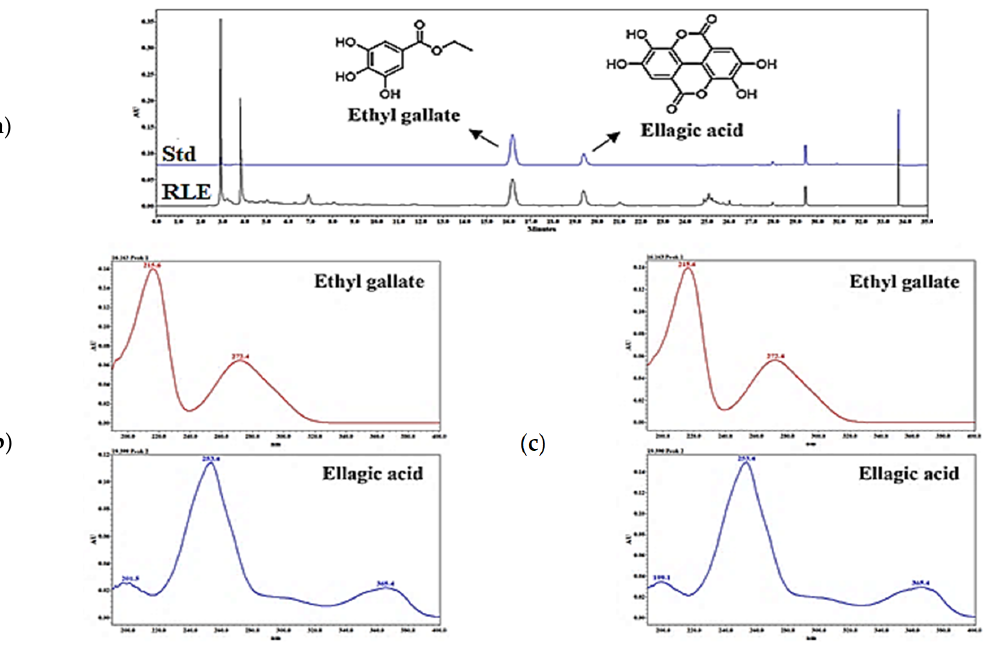
Figure 2. High − performance liquid chromatography (HPLC) chromatogram of the marker com ‐ pound ( a ) Chromatogram of standard and R. davurica Pall. leaf extract (RLE); ( b ) Ultraviolet (UV) spectrum of the standard; ( c ) UV spectrum of RLE.